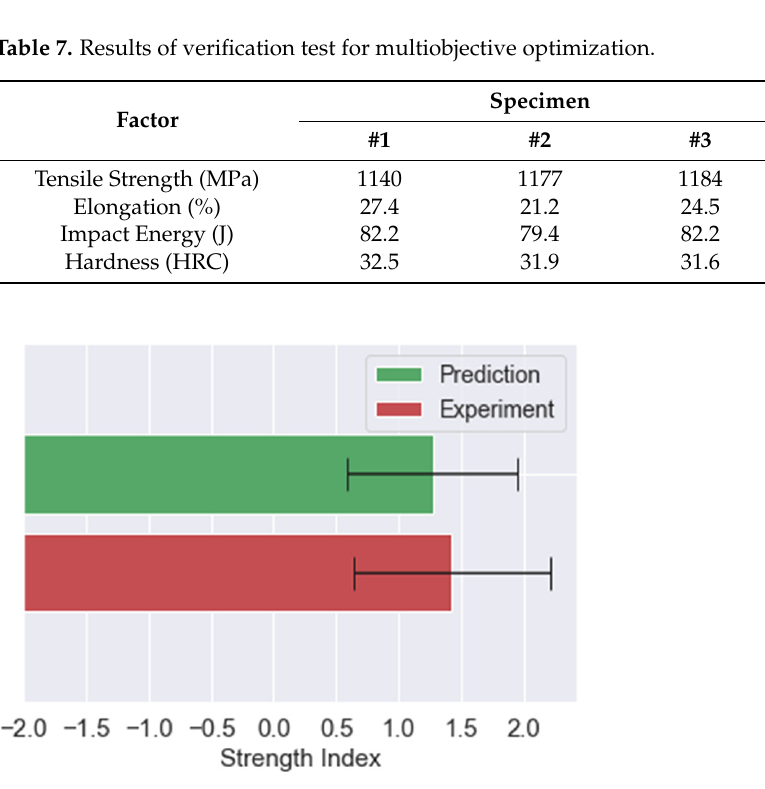
Figure 6. Strength index of multiple properties with 95% confidence interval.